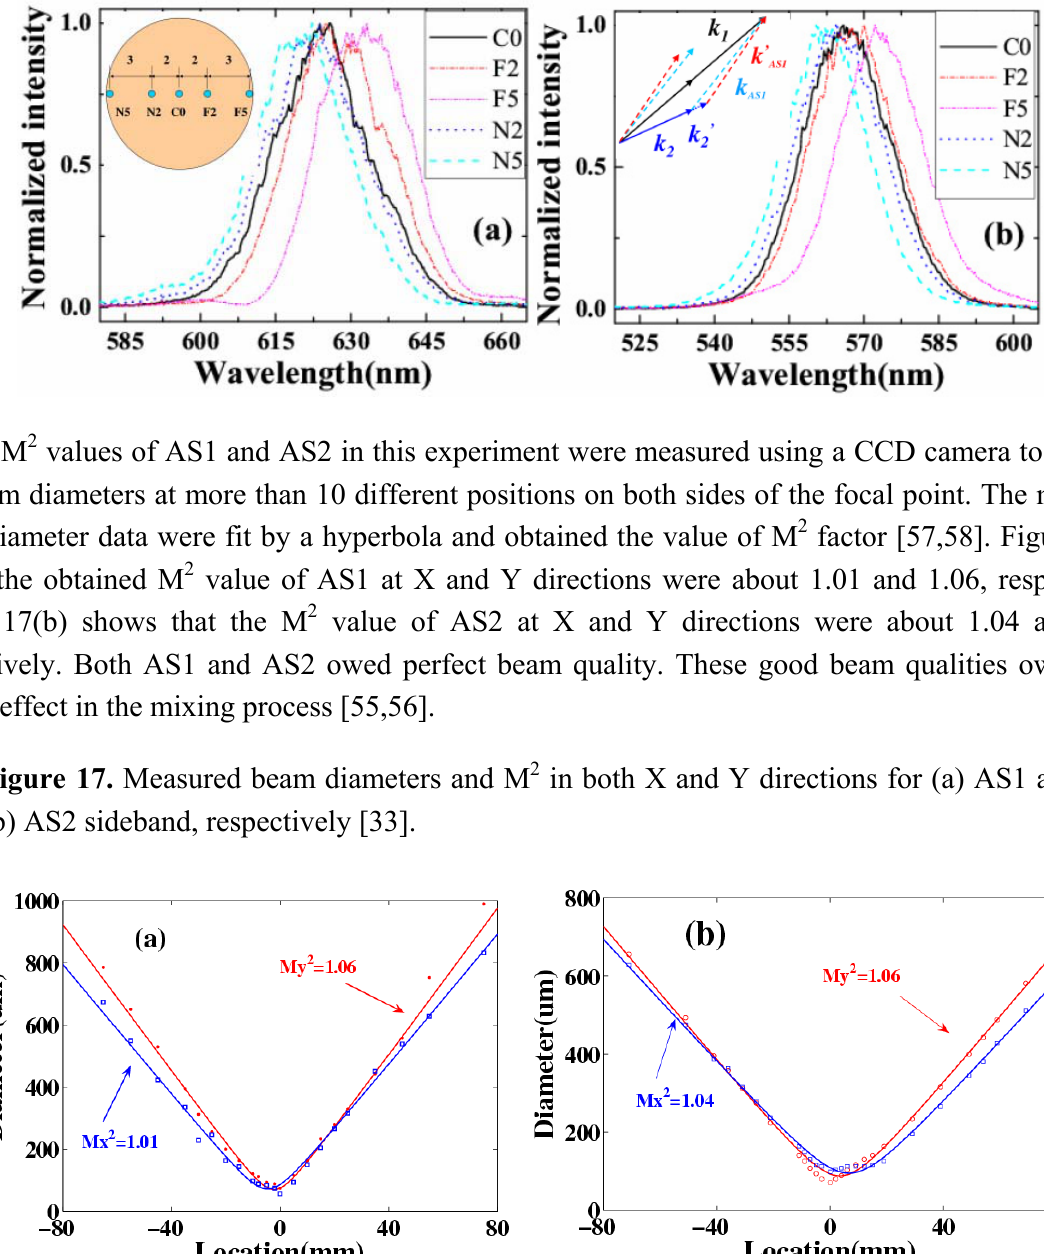
Figure 16. The inset pattern in Figure (a) shows the five different positions on the beam we measured. (a) and (b) show the spectra at the five different positions on the AS1 and AS2 sidebands, respectively. The inset of Figure (b) shows the phase matching geometry, which indicates longer wavelength on the side far from the two input beams [33].